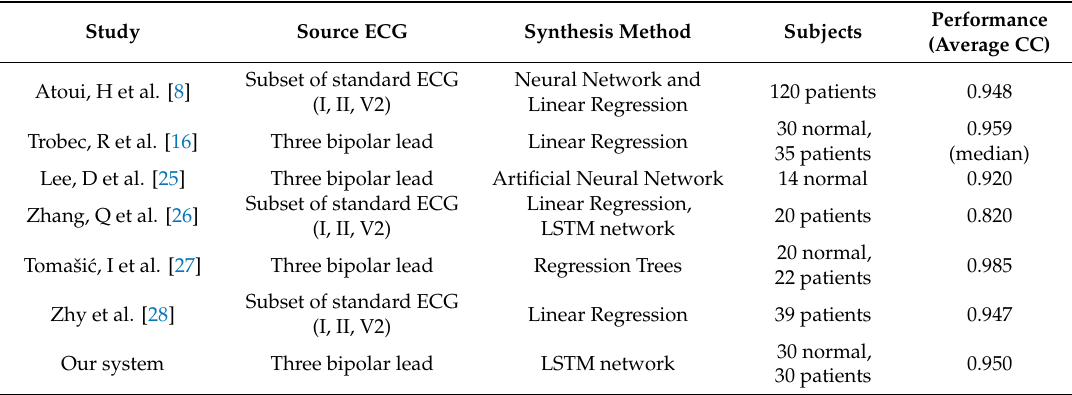
Table 4. Previous studies on reconstruction